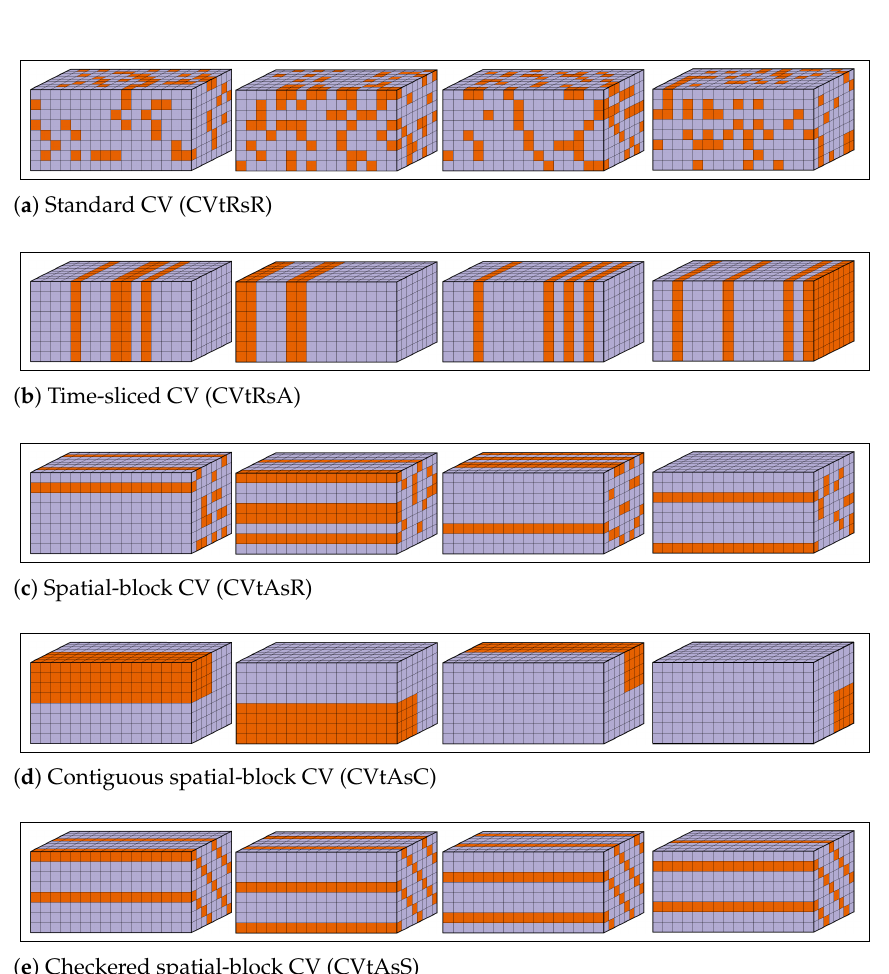
Figure 2. Cross-validation methods. The folds used for training are in lighter lilac, while the folds used for testing are in dark